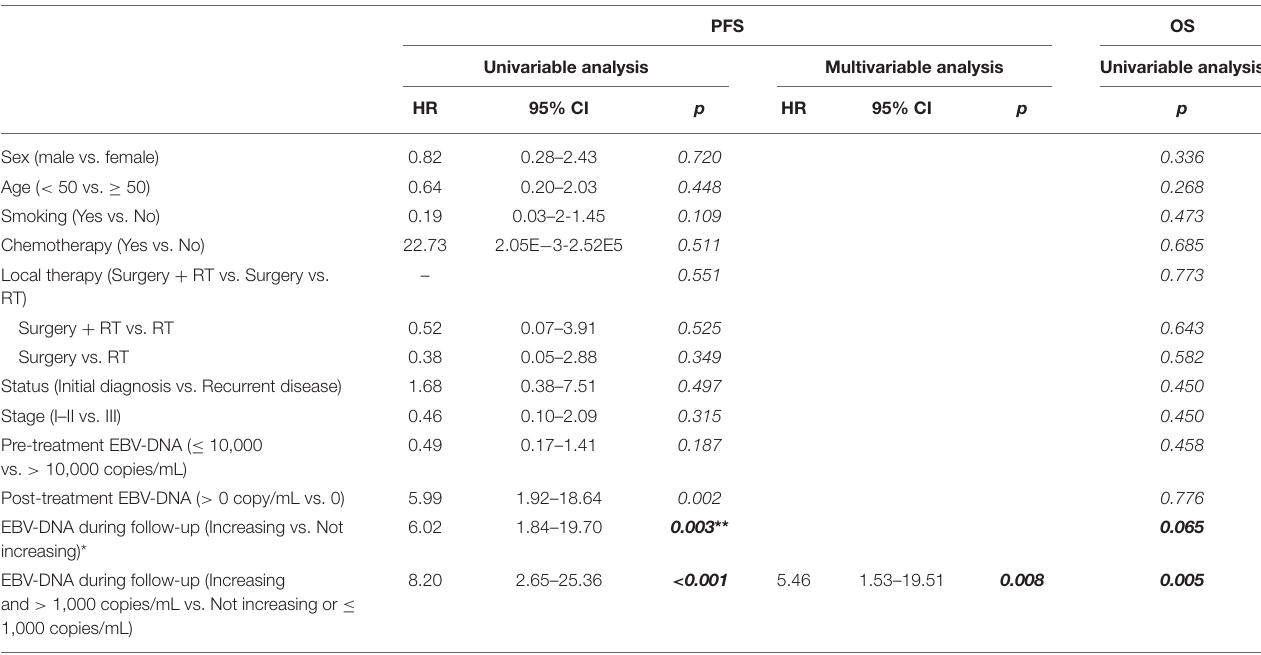
TABLE 5 | Univariable and multivariable Cox regression analyses in the full data